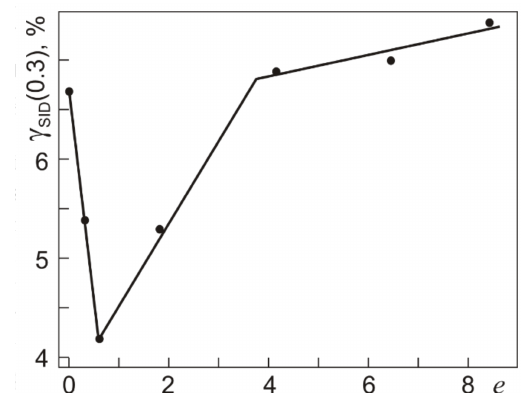
Figure 9. Total reversible inelastic strain γ SID ( τ 0.3 ) recovered by Ti 49.8 Ni 50.2 after torsion with τ = τ 0.3 (295 K) and heating (500 K) at di ff erent true strains e specified in warm abc pressing. Residual plastic strains γ pl =